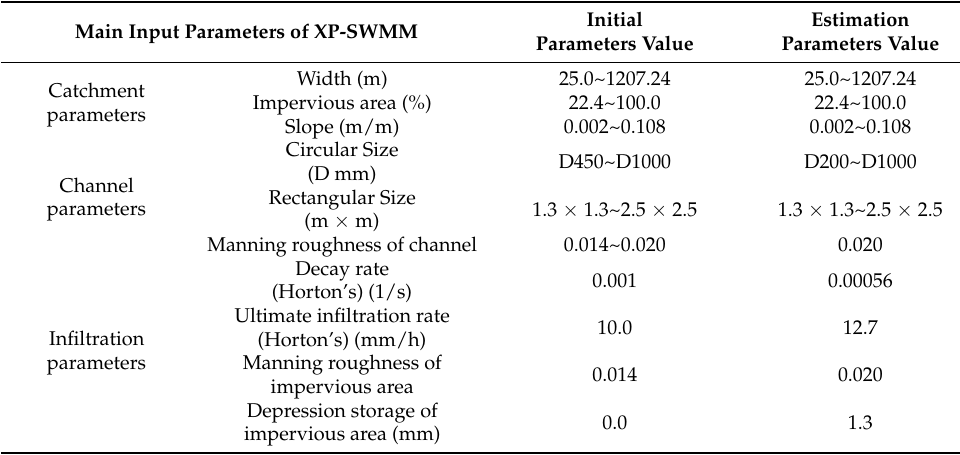
Table 3. Estimation results of the main parameters (Gunja watershed).